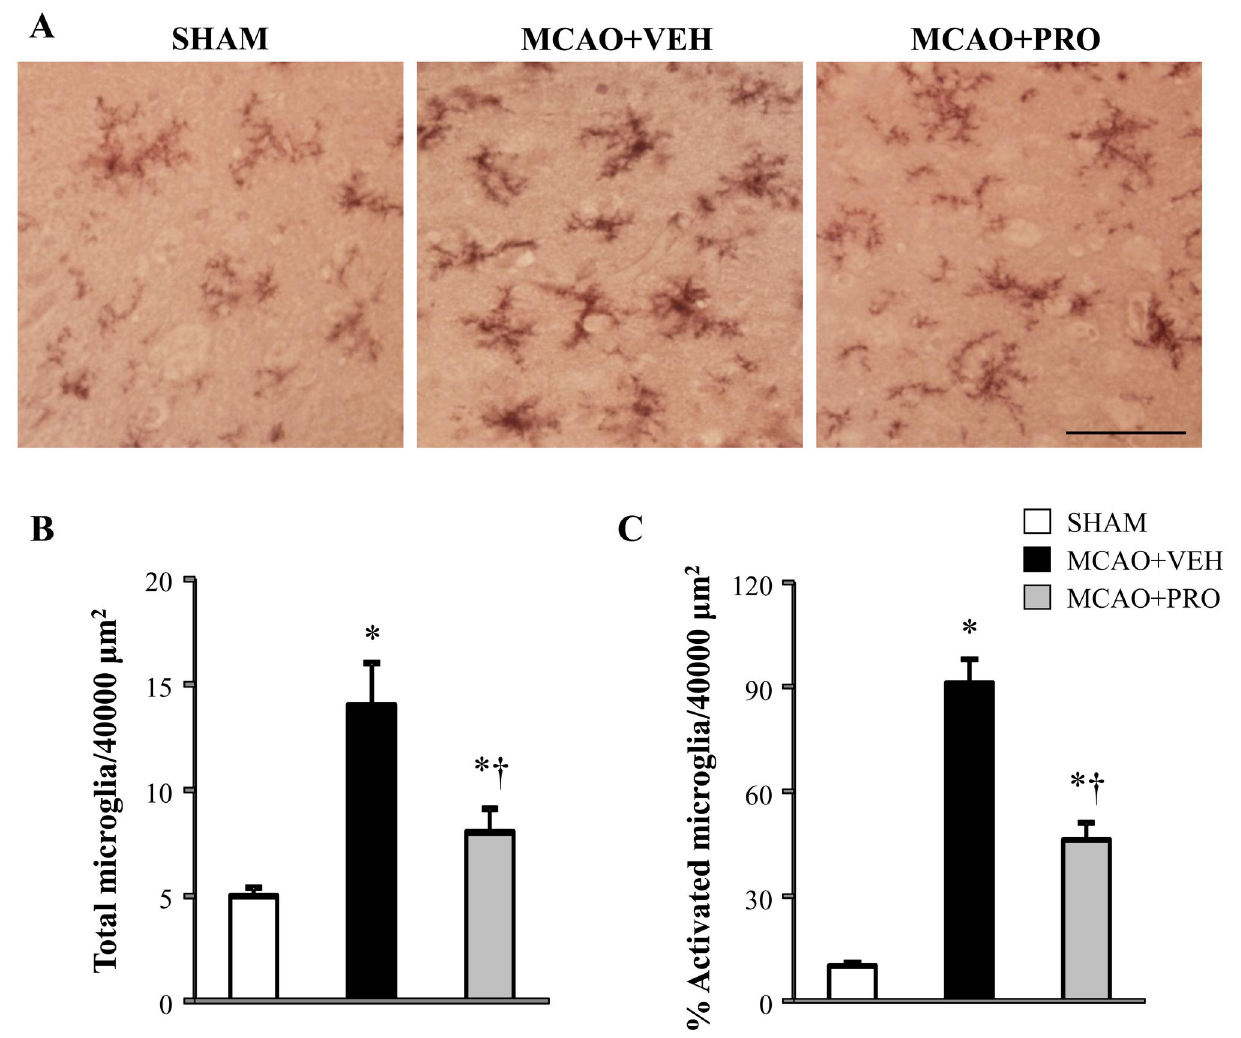
Figure 3. Representative photomicrographs of microglia stained with CD11b (A), total number of microglia (B) and the proportion of activated microglia (expressed as percent of total microglia) (C) in the peri-infarct cortical tissue 24 h after MCAO in rats treated with VEH or PRO. SHAM rats without treatment were used as control. Activated microglia were defined as strong CD11b immunoreactivity, an enlarged soma, and fewer and shorter processes. Scale bar, 200 μm. Values are mean ± SEM (n = 4 for each group). * P < 0.05 vs. SHAM, † P < 0.05 MCAO+PRO vs.